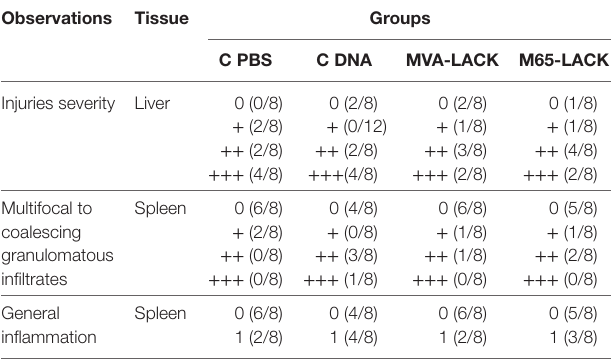
Severity of histopathological findings: non-existent (0), mild ( + ), moderate ( ++ ), severe ( +++ ), and general inflammation (1). (n/n), number of animals with the given severity of the histopathological feature within each group.